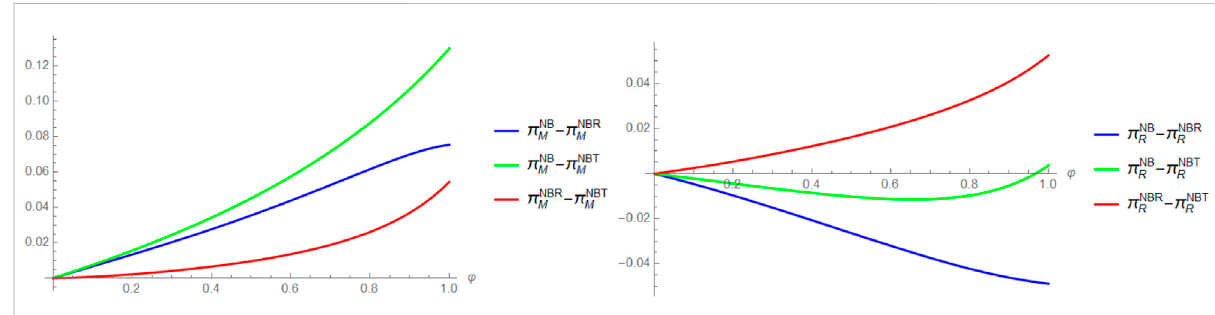
FIGURE 4 Comparison of the different manufacturer and retailer ’ pro fi ts in the scenario without adopting blockchain technology.